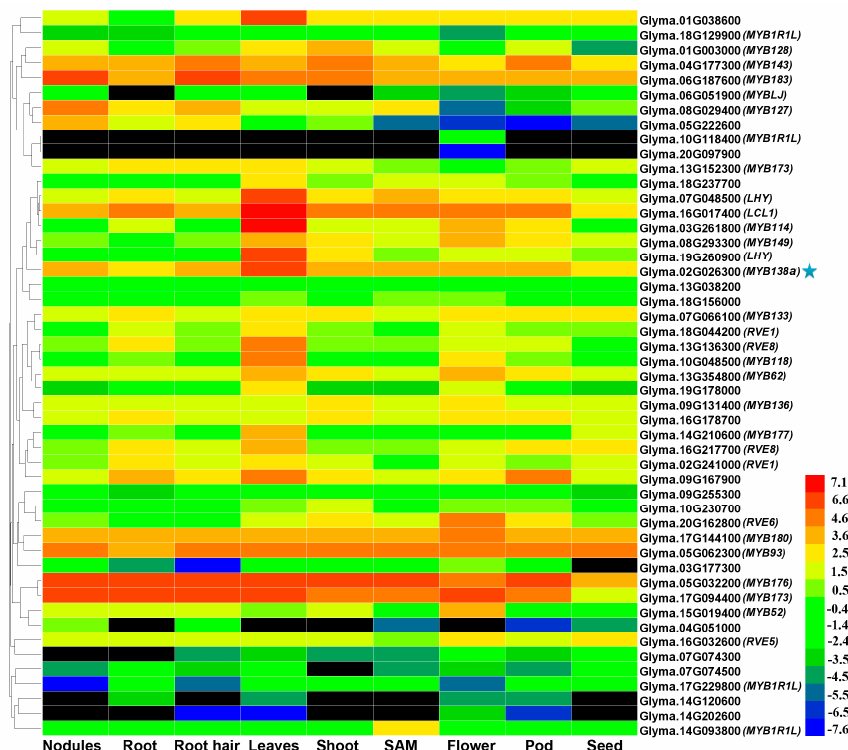
Figure 3. Expression patterns of CCA1-like genes in soybean. The transcript profiling data of CCA1-like genes in different soybean tissues were retrieved from Phytozome database (Available online: http://www.phytozome.net) for heat map generation. The colored scale bar beside the heat map indicates gene expression level. SAM, shoot apical meristem. GmMYB138a (Glyma.02g026300) is marked with a star